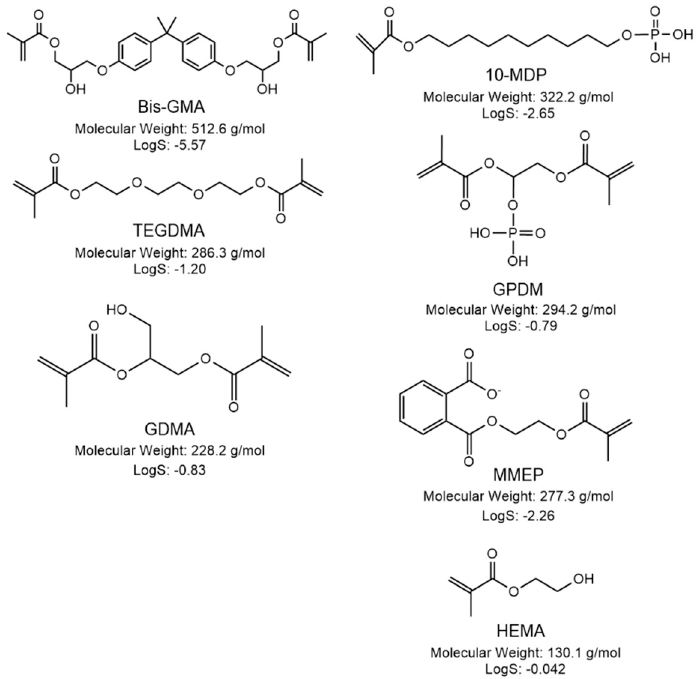
Figure 1. Chemical structure and properties (molecular weight and solubility in water—LogS) of monomers used in the bonding systems.